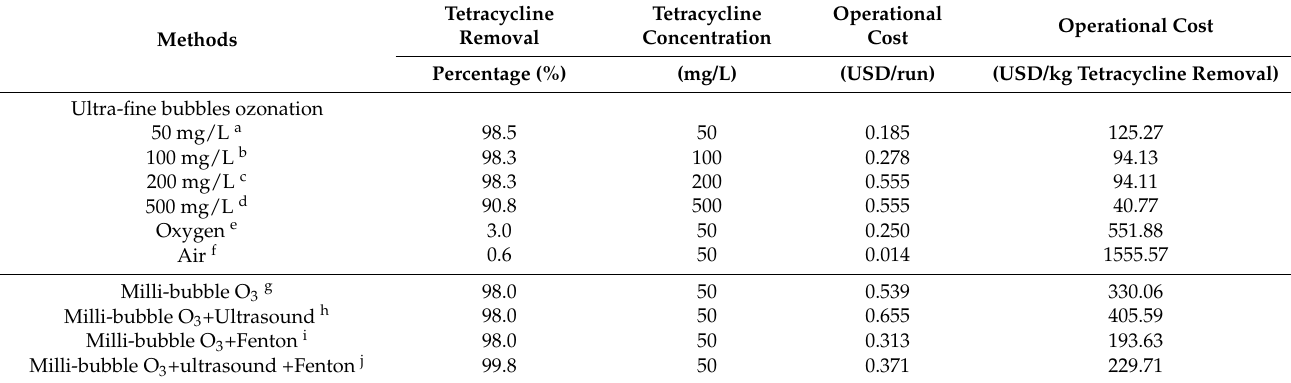
Table 4. Degradation and mineralization of tetracycline by ultrafine-bubble ozonation at different reaction